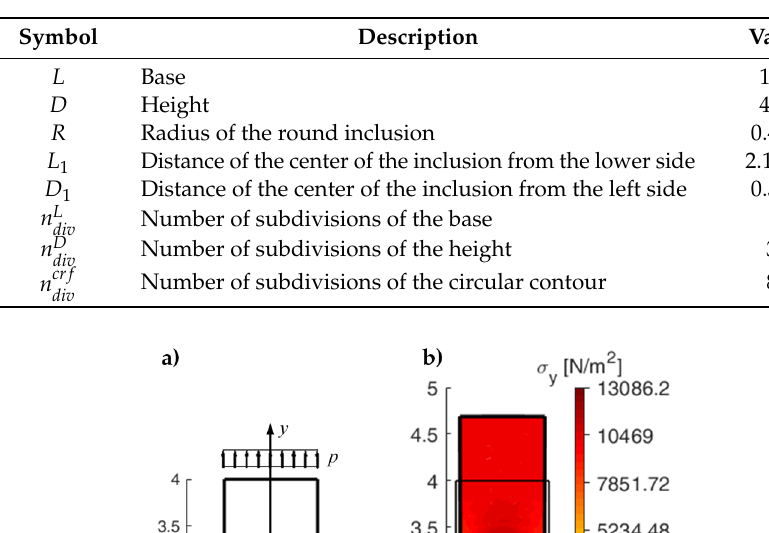
Table 2. Geometric parameters of the discrete element used in the DECM analysis.